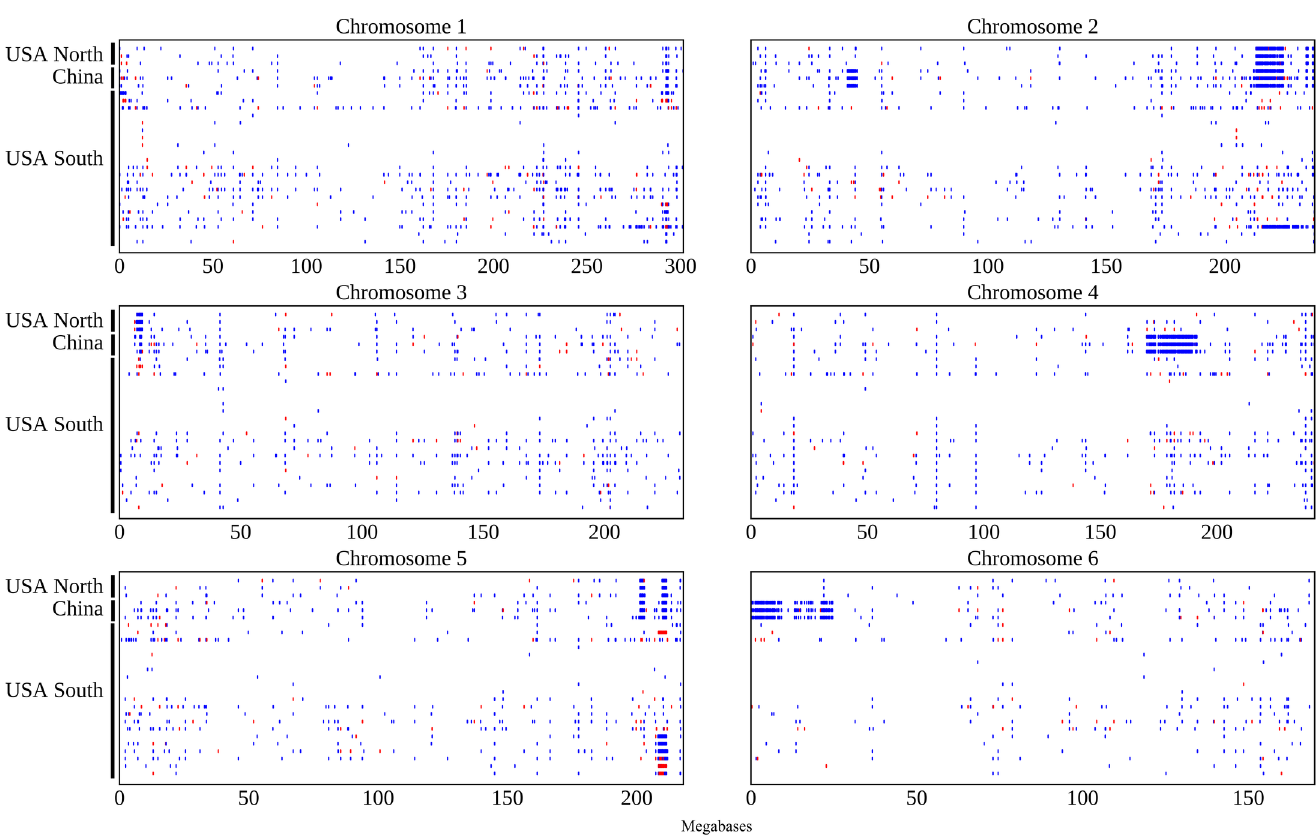
Fig 2. SNP distribution pattern for each of the 27 samples on each of the first 6 chromosomes of maize. Non-reference-like homozygous genotypes are indicated in blue and heterozygous genotypes in red. The sample order from top to bottom on Y-axis in each sub-figure is the same order displayed as in Fig